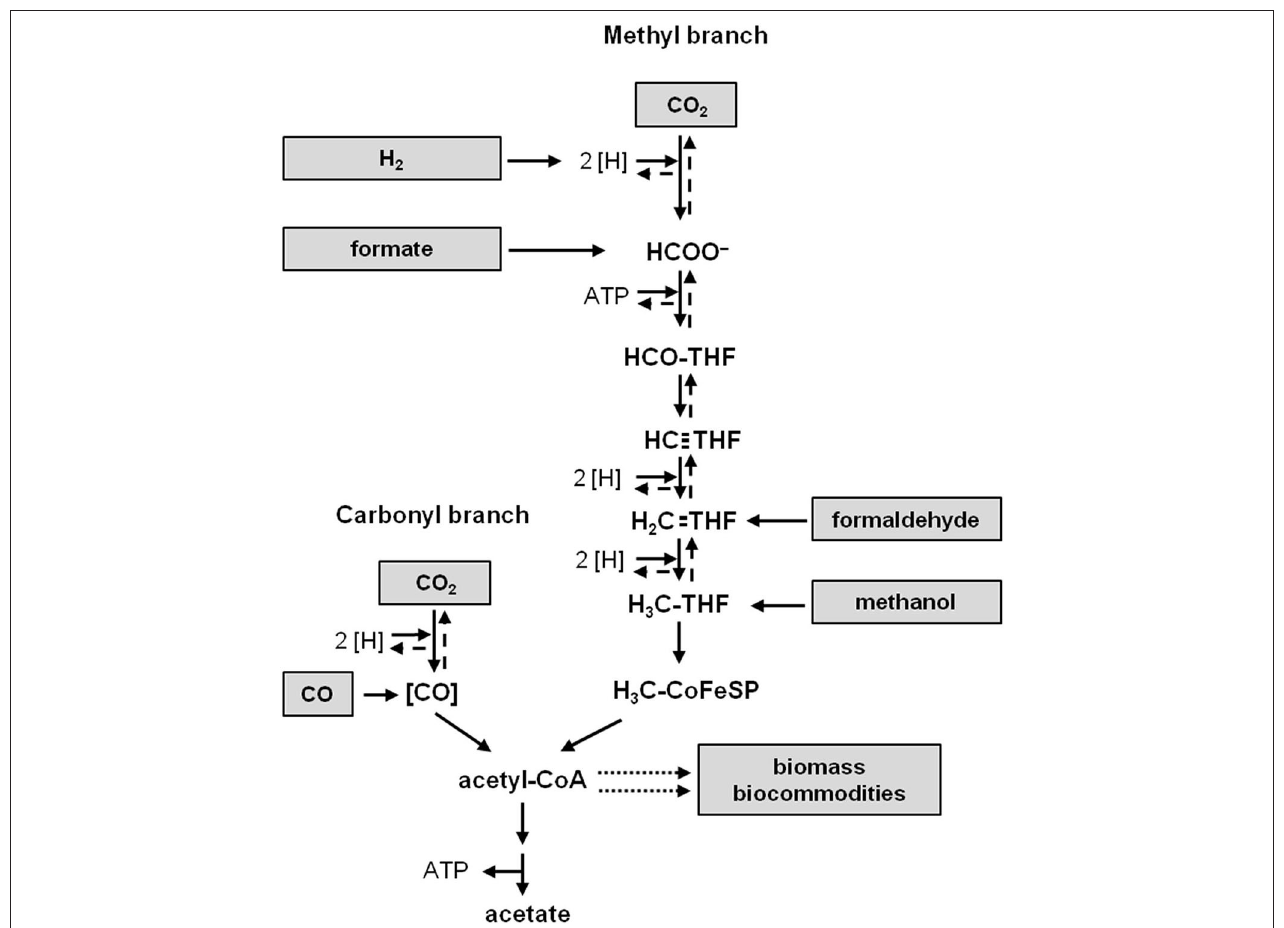
FIGURE 1 | The Wood-Ljungdahl pathway of CO 2 reduction. Substrates fed directly into the pathway are shown to the left and right. Acetyl-CoA is the precursor of biomass and biocommodities (dotted arrows). [H], reducing equivalents; THF, tetrahydrofolic acid; [CO], enzyme-bound CO; large dashed arrows, oxidative direction of the